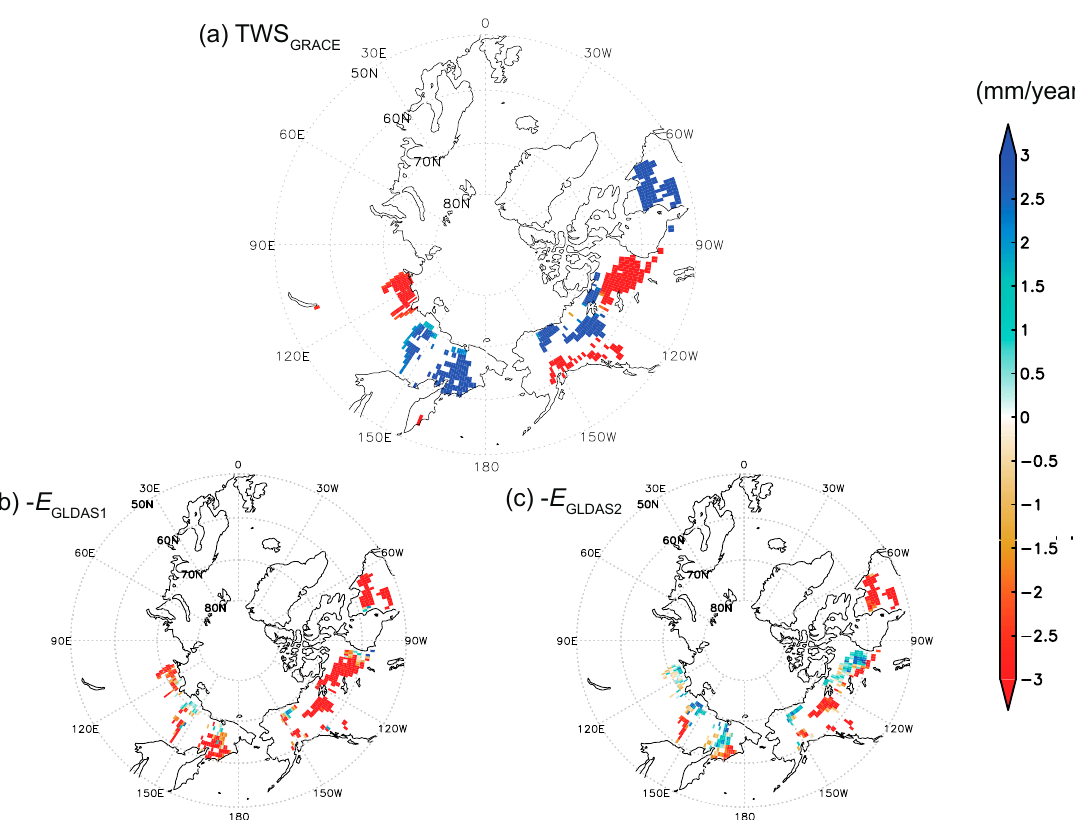
Figure 5. Spatial distribution of the slopes of temporal linear trends in each water balance component from 2002 to 2016 when p < 0.05 (linear trend in TWS GRACE ). ( a ) TWS GRACE , ( b ) − E GLDAS1 . ( c ) − E GLDAS2 . Table 2. Spatial correlation coefficients of the regional linear trends between TWS GRACE and P or E . N denotes sample